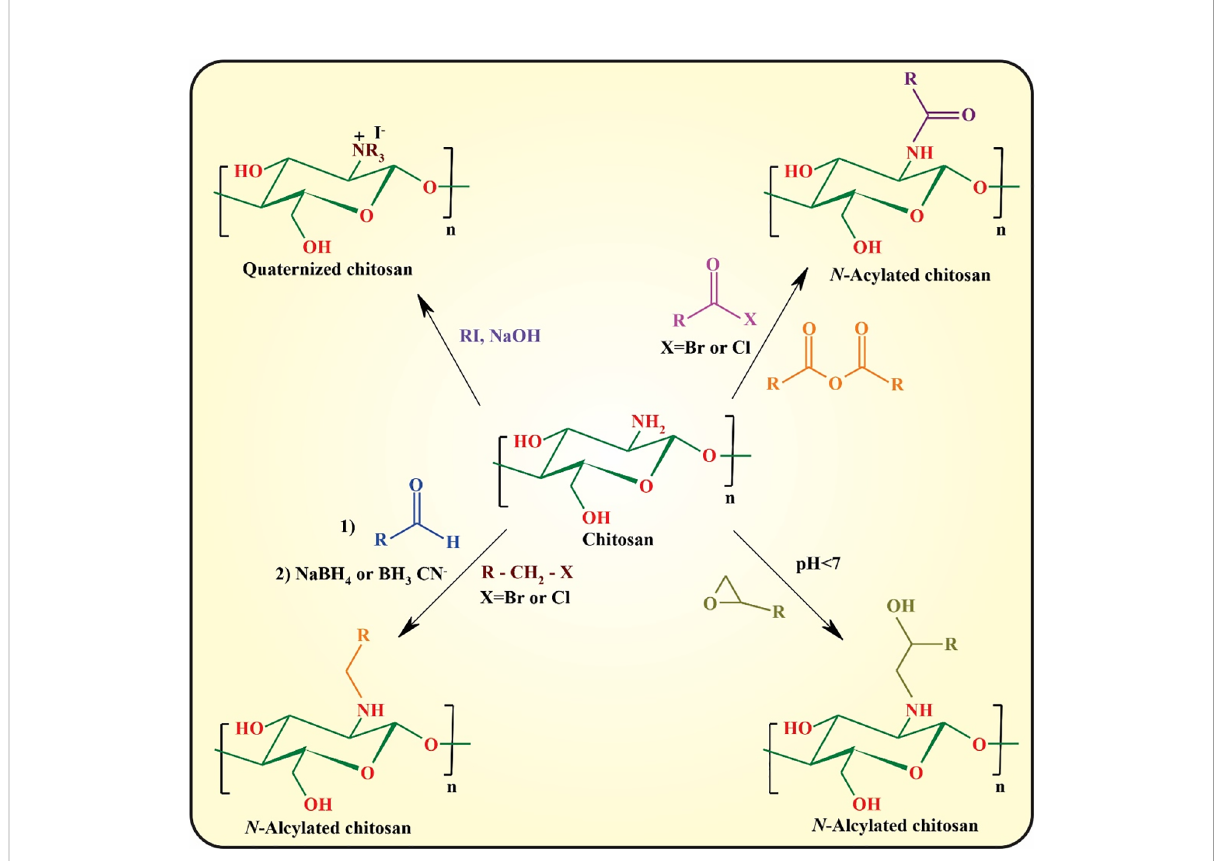
FIGURE 4 N -substitution of chitosan by different